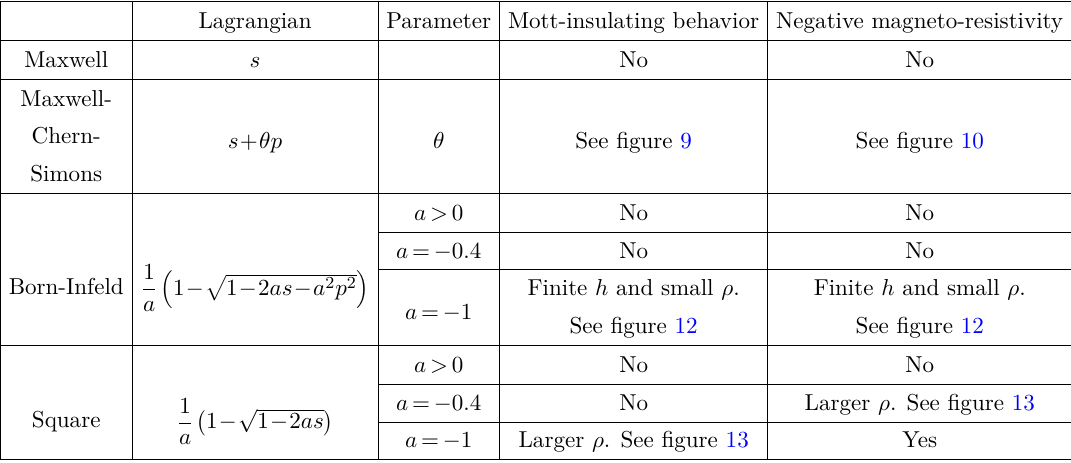
Table 1 . Conclusion of Mott-insulating behavior and negative magneto-resistivity for various NLED models at zero temperature T = 0